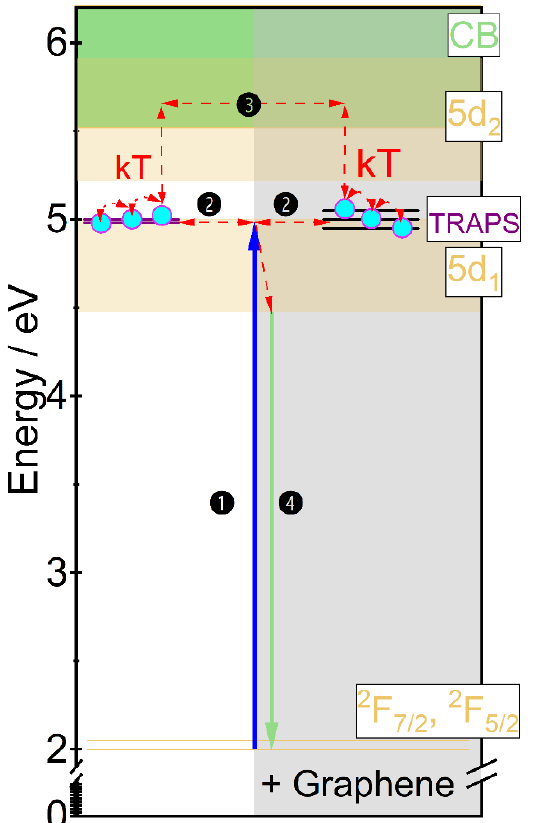
Figure 10. Mechanism of persistent luminescence proposed for the Gd 2.994 Ce 0.006 Ga 3 Al 2 O 12 and Gd 2.964 Ce 0.006 Dy 0.03 Ga 3 Al 2 O 12 ceramics with graphene